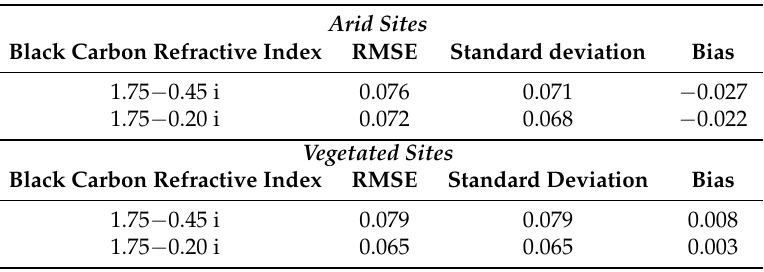
Table 6. Performances, for the stable cases, of aerosol optical thickness (AOT) at 550 nm estimated by the MACCS-ATCOR Joint Algorithm (MAJA) using five CAMS (Copernicus Atmosphere Monitoring Service) aerosol types, and two different Black Carbon refractive indices. RMSE: root-mean-square error.